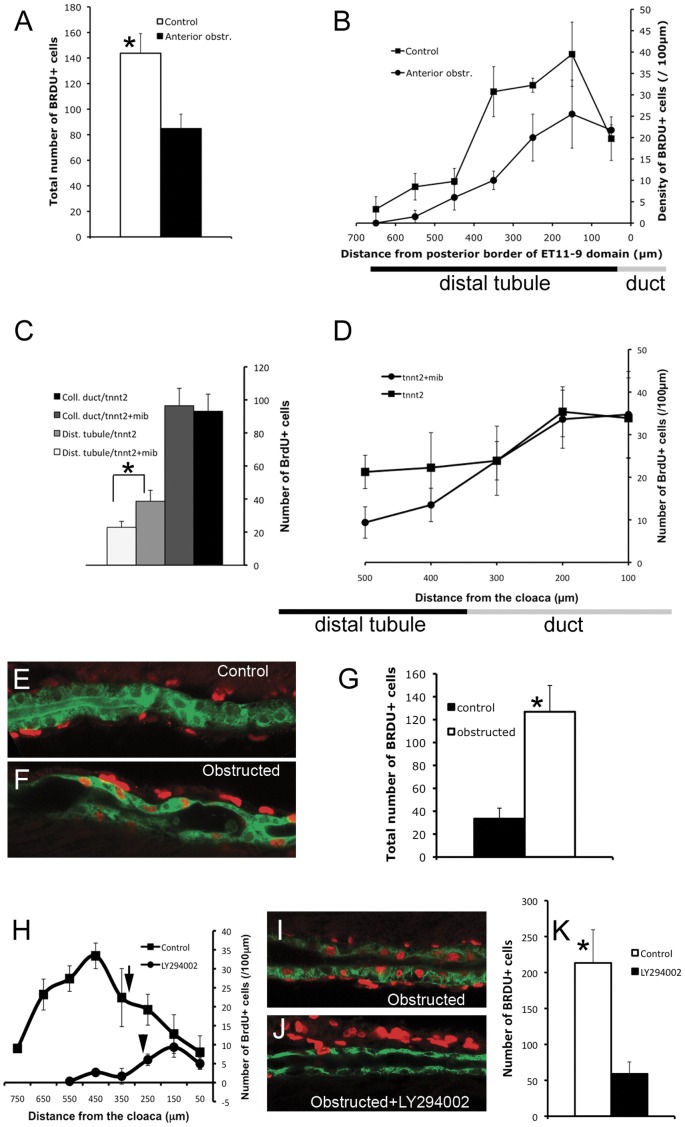
Collective epithelial migration stimulates cell proliferation in the distal tubule.(A, B) Cell proliferation in the distal tubule (ET11-9 GFP domain) after anterior obstruction. Obstruction was induced at 30 hpf, BrdU incorporation was assessed between 2 and 3 dpf. (A) Total number of BrdU+ nuclei in the distal ET11-9 domain. White bar: control (n = 4), black bar: anterior obstruction (n = 4). P = 0.01. (B) Spatial distribution of the BrdU-positive nuclei per 100 µm length of the distal tubule (measured from the posterior border of the ET11-9 domain). Squares: control (n = 4), Circles: anterior obstruction (n = 4). (C,D) Cell proliferation in the distal nephron in mindbomb mutants. mindbomb (mib) heterozygotes were in-crossed and injected with tnnt2 morpholino to control for vascular defects in mib mutants. BrdU incorporation was assessed between 2 and 3 dpf. Homozygous mib mutants were separated from their siblings based on their axis curvature phenotype. (E) Total amount of BrdU incorporation in pronephric duct (black bar: control, n = 8; dark-grey bar: mindbomb, n = 8; P>0.05) and in the posterior distal tubule (light grey bar: control, n = 8; white bar: mindbomb, n = 8; P<0.01). (D) Linear density of the BrdU+ nuclei. Squares: tnnt2MO only control (n = 4); circles: mindbomb +tnnt2MO (n = 4). The underlying bars (B,D) indicate the position of distal tubule/pronephric duct border. (E) 24 hour BrdU incorporation in the posterior proximal tubule (2–3 dpf). (F) BrdU incorporation during 24 hour post-obstruction (2–3 dpf). (G) total number of BrdU positive nuclei in the distal 600 µm of proximal tubule. Black bar: control (n = 4), white bar: obstructed nephrons (n = 8); P<0.01. (H) Proliferation profile in control ET11-9/Tg(atp1a1a.4:GFP) transgenic fish compared to LY294002 treated fish (2–3 dpf). Arrows point to the location of distal tubule/pronephric duct interface. (I) Up-regulation of BrdU incorporation in stretched proximal tubule between 12 and 36 hours post-obstruction. (J) BrdU incorporation was markedly reduced in LY294002 treated, obstructed tubules. (K) Total number of BrdU-positive nuclei in the anterior 500 µm of the proximal tubule. White bar: BrdU incorporation in obstructed nephron/−LY294002 (n = 3), black bar: BrdU incorporation in obstructed nephron/+LY294002 (n = 3); P<0.05. (E,F) Green: GFP (ET33d10 GFP); (I,J) Green – cadherin17; (E,F,I,J) Red: BrdU.